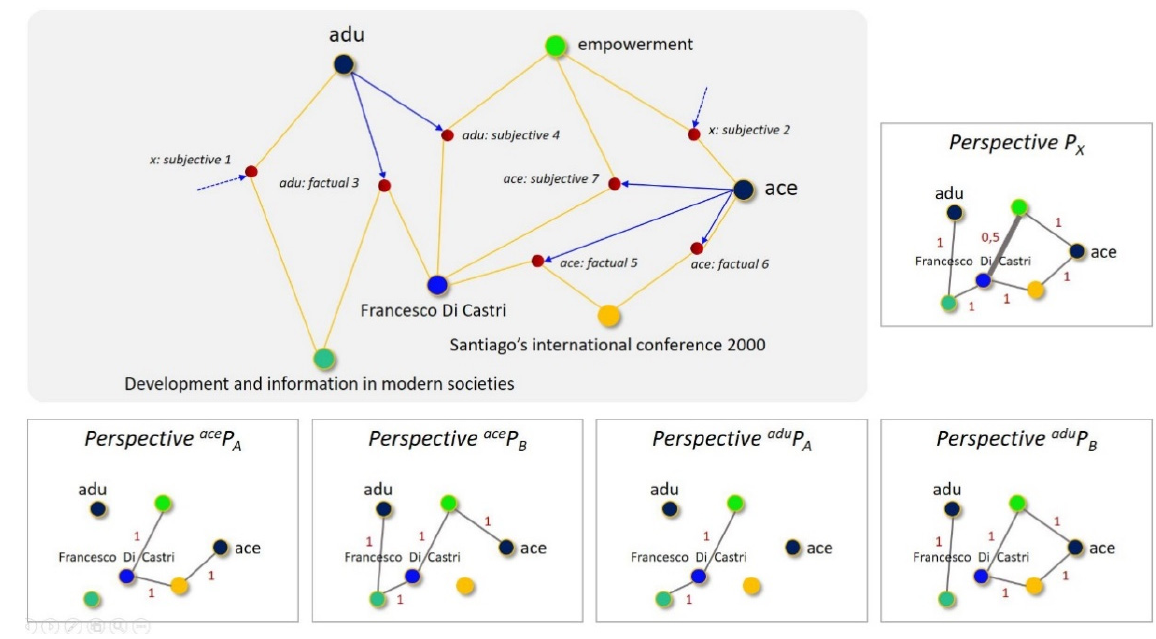
Figure 5. Given a knowledge graph, five distinct perspectives yield five different knowledge maps.